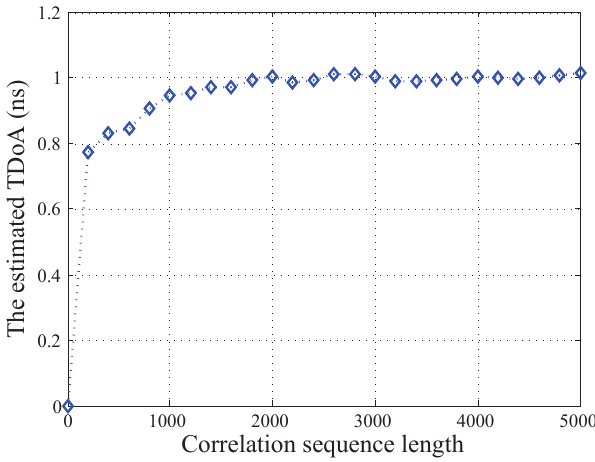
Figure 4. Estimated TDoA vs. correlation sequence length N (1 ns